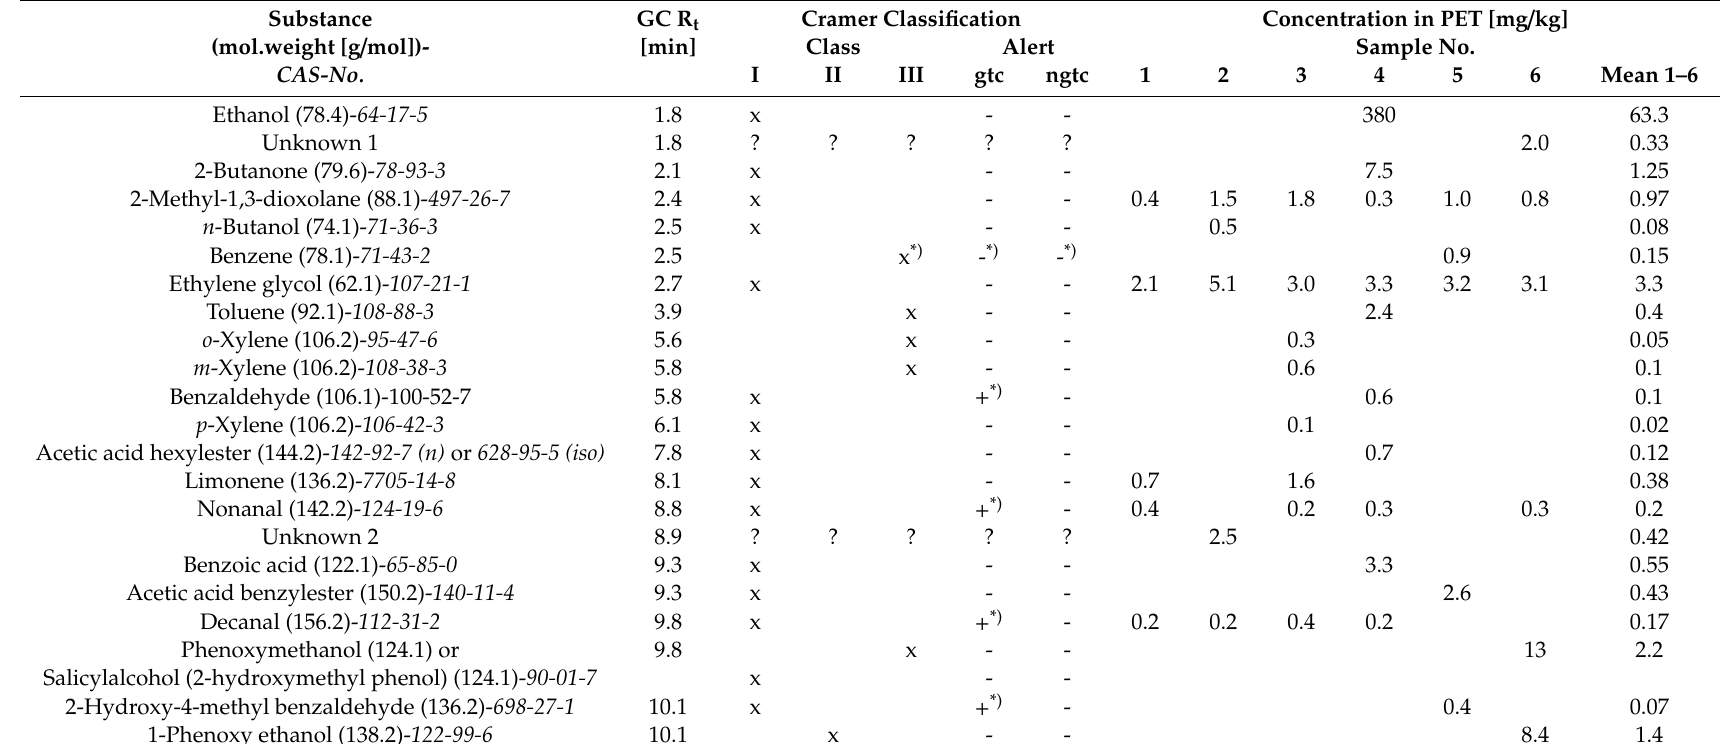
Table 1. Substances found in PET bottles originally used for dishwashing products. Substance GC R